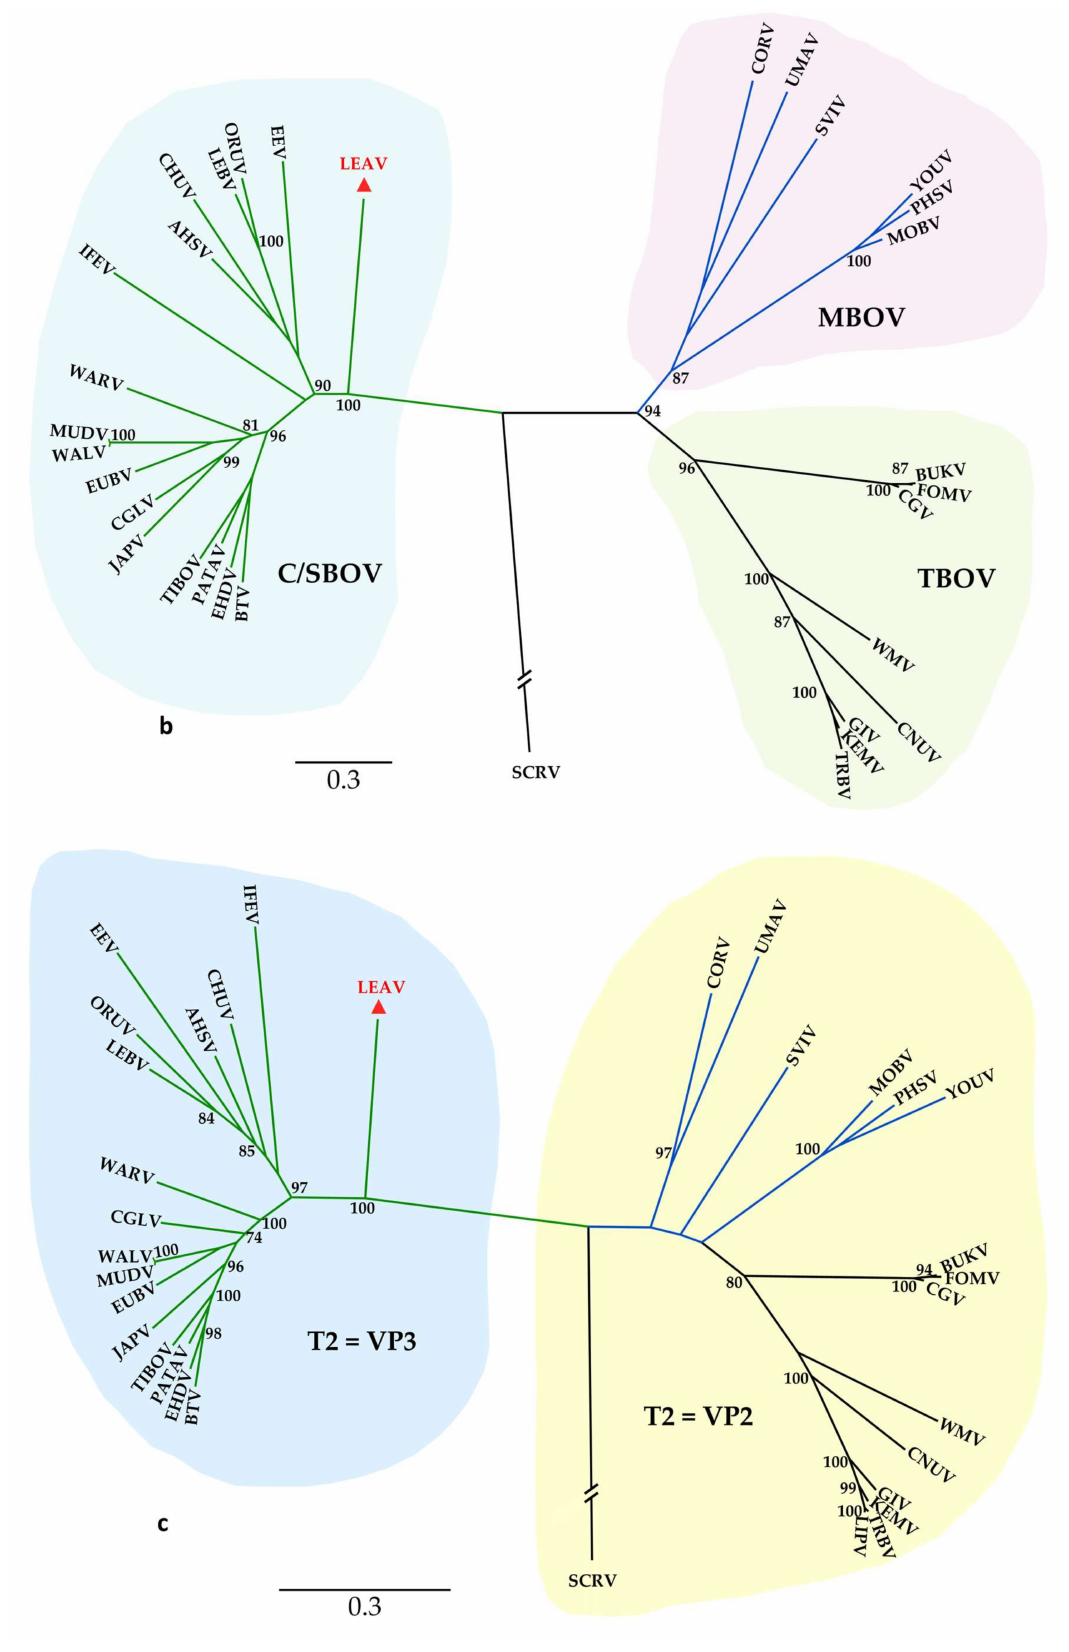
Figure 2. Maximum likelihood phylogeny of the VP1 ( a ), T13 (VP7) ( b ) and T2 ( c ) orbivirus proteins constructed using maximum likelihood inference and 100 bootstrap